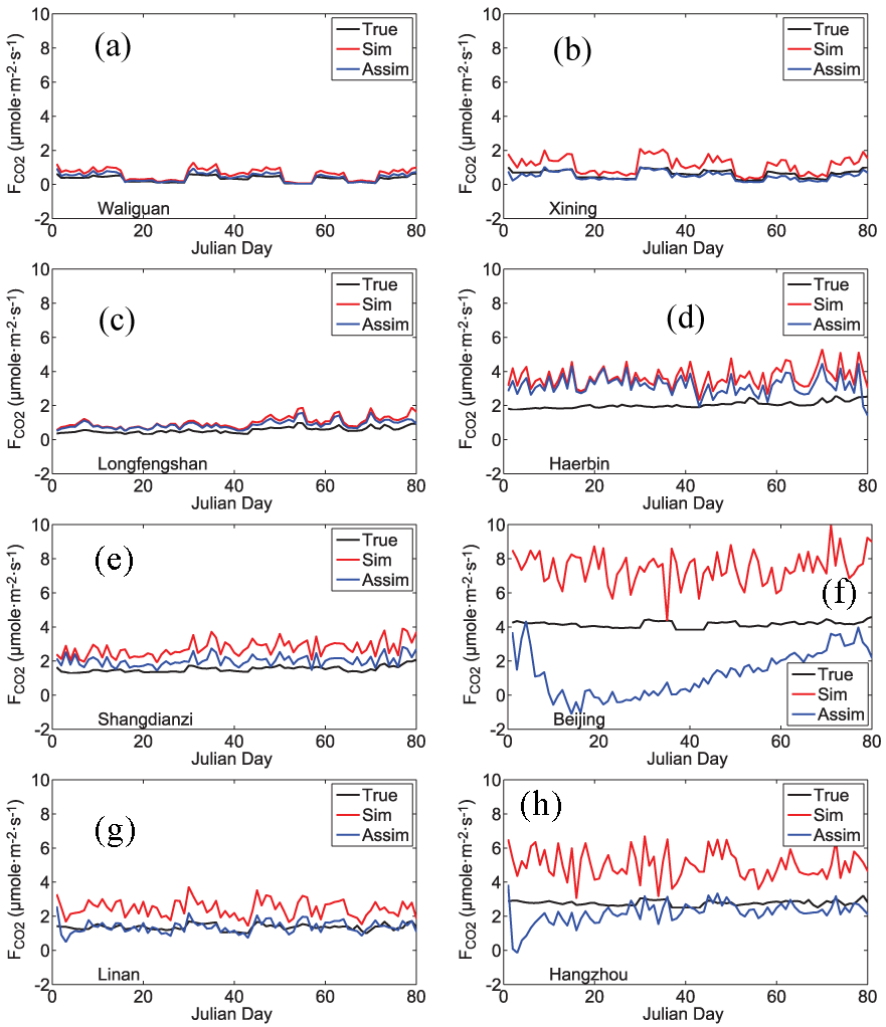
Figure 10. Daily mean time series of CO 2 fluxes at national background stations in China and their nearest large cities from 1 January to 20 March 2010, extracted from the prior true surface CO 2 fluxes F p t (black), the prescribed CO 2 surface fluxes F ∗ t (red), and the assimilated CO 2 fluxes F a t (blue). All time series were interpolated to the observation locations by the spatial bilinear interpolator method. The sites used are (a) Waliguan, (b) Xining, (c) Longfengshan, (d) Haerbin, (e) Shangdianzi, (f) Beijing, (g) Linan, and (h)